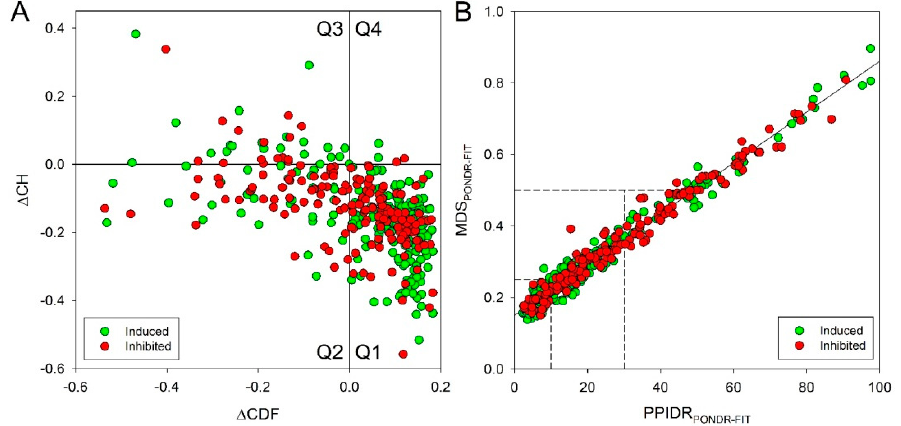
Figure 9. Global intrinsic disorder predisposition of 219 induced (green circles) and 175 inhibited proteins (red circles) in the CSC-like BSC8_SORE+ cell line vs. the original population of the BSC8 cell line. ( A ) CH-CDF plot analysis. Quadrants are numbered in a clockwise direction starting with Q1 in the lower right and ending with Q4 in the upper right. The following characterize proteins within each quadrant: Q1 (lower-right quadrant)—proteins predicted to be ordered by both predictors, Q2 (lower-left quadrant)—proteins predicted to be ordered by CH but disordered by CDF, Q3 (upper-left quadrant)—proteins predicted to be disordered by both predictors, and Q4 (upper-right quadrant)—proteins predicted to be disordered by CH and ordered by CDF. ( B ) Correlation of the mean disorder scores (MDS) and PPDRs based on the results of the PONDR ® FIT analysis. Dashed lines represent boundaries separating ordered (MDS < 0.25, PPDR < 10%), moderately disordered (0.25 ≤ MDS < 0.5, 10% ≤ PPDR < 30%), and highly disordered proteins (MDS ≥ 0.5, PPDR ≥